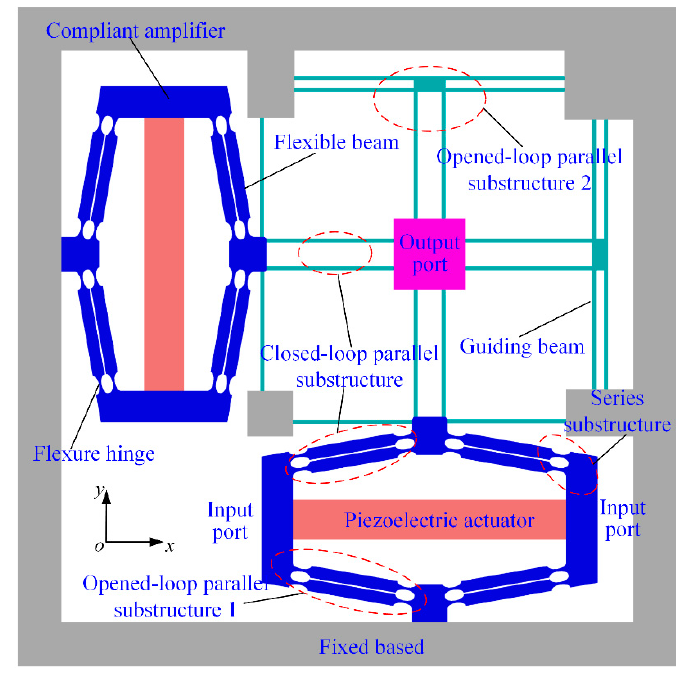
Figure 8. The 2-DOF precision positioning platform.